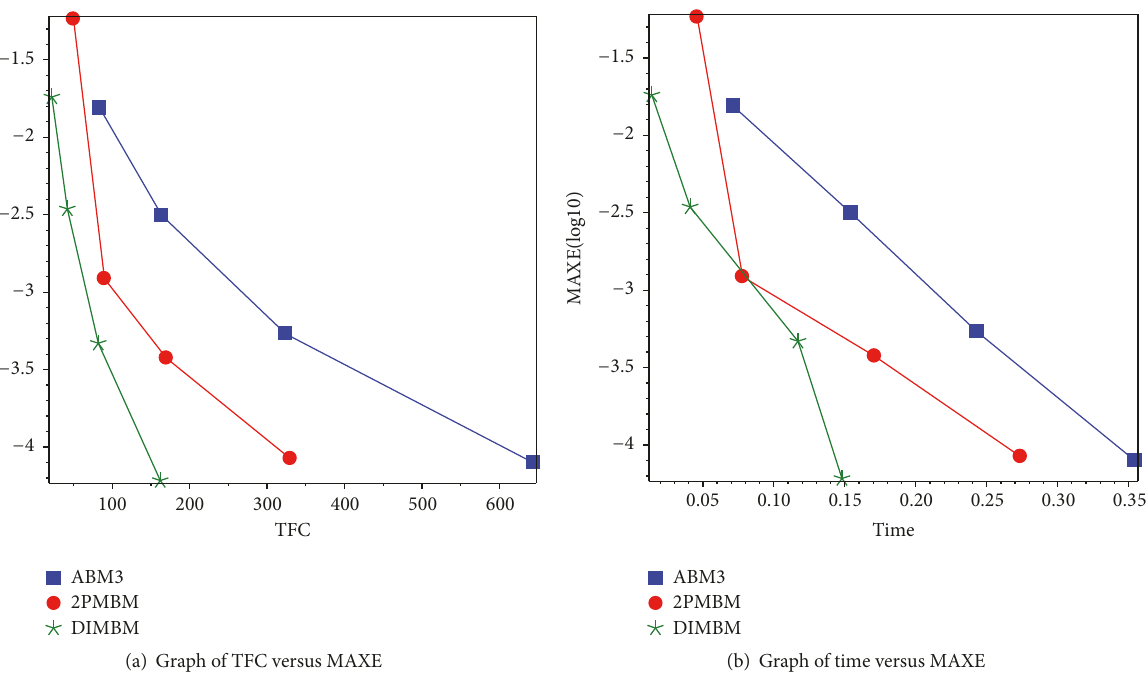
Figure 4: Graph of the numerical results when solving Example 2.